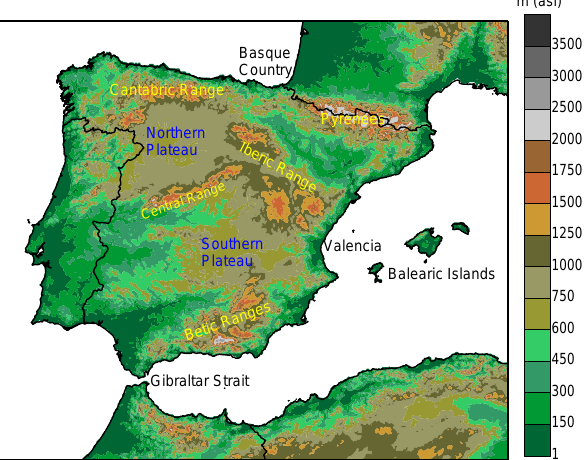
Fig. 2. Daily precipitation records for the Iberian peninsula from 1931 to 1960. Colors indicate precipitation according to the scale Figure 2.- Daily precipitation records for the Iberian peninsula from 1931 to 1960. (from Font, Colors indicate precipitation according the scale (from Font,1983)